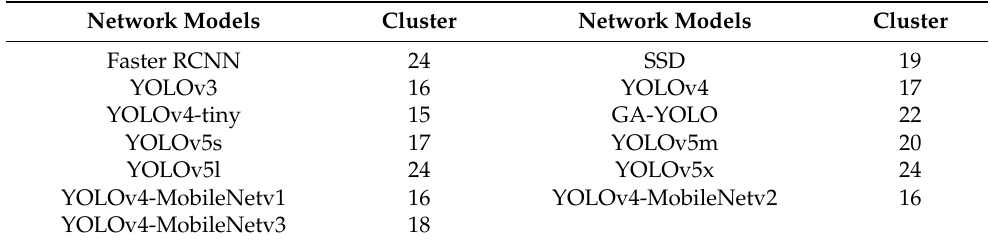
Table 10. Number of grape clusters detected by 13 network